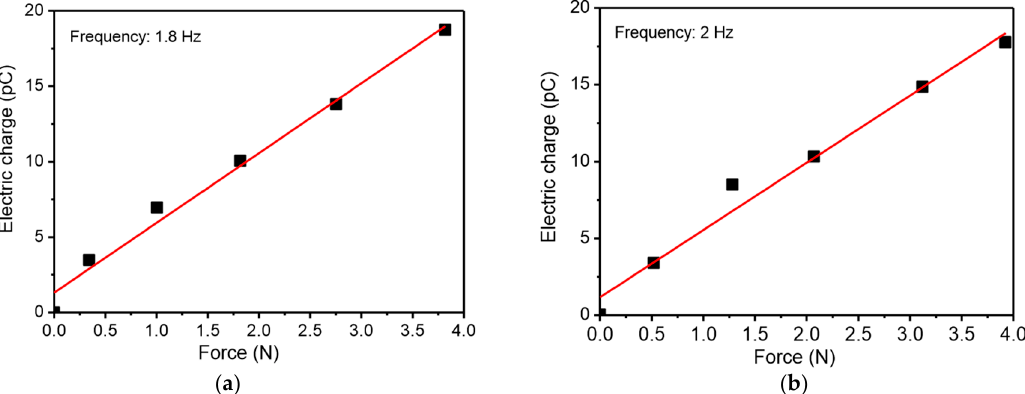
Figure 3. Electrical output of the piezoelectric pressure sensor as function of the applied force on the active area at different frequencies, ( a ) 1.8 Hz and ( b ) 2